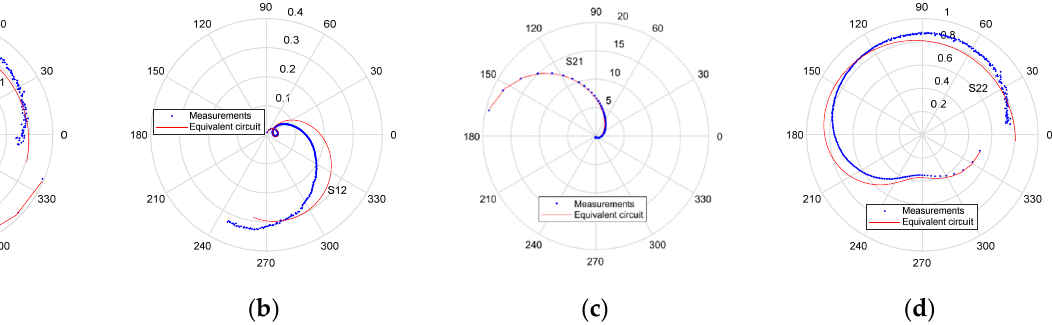
Figure 7. Measured (blue symbols) and equivalent-circuit simulated (red lines) behavior of ( a ) S 11 , ( b ) S 12 , ( c ) S 21 , and ( d ) S 22 with the frequency range spanning from 200 MHz to 65 GHz for the DUT at V DS = 30 V, V GS = − 3.1 V, and T a = 90 °C.